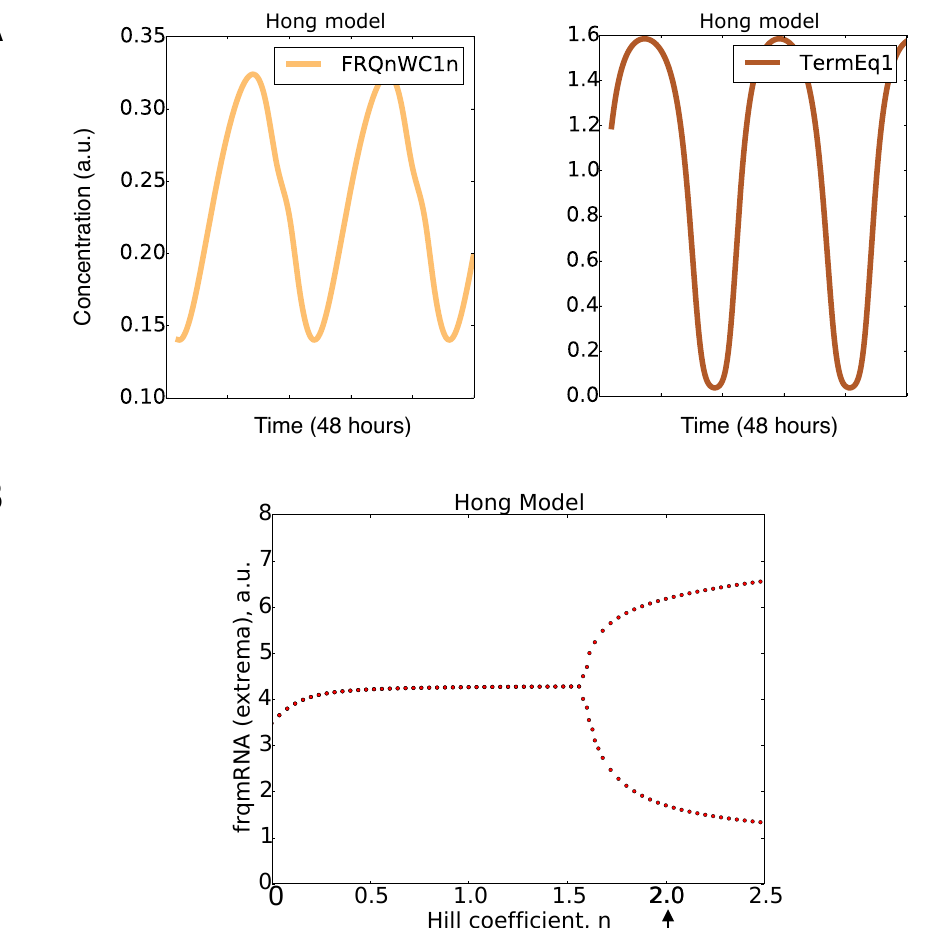
Figure A7. Comparisons with the Hong model [15]: ( A ) There are no double peaks of the FRQnWC1n complex and a less pronounced switch (compare Figure 3). ( B ) The Hopf bifurcation is shifted to higher Hill coefficients (compare Figure